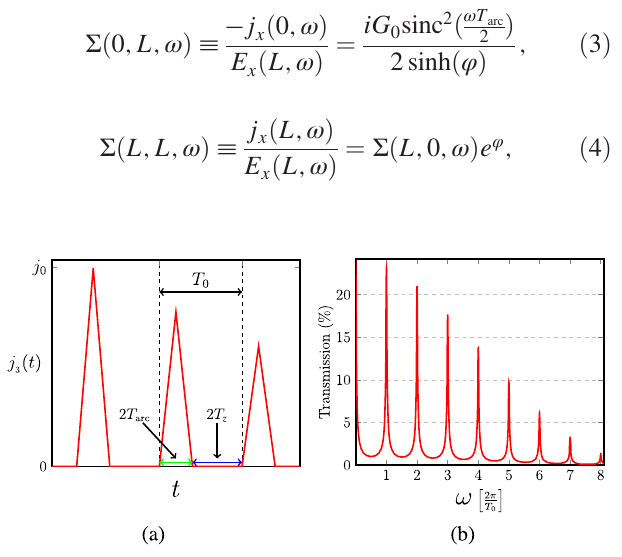
FIG. 3. (a) A sketch of real-time current on the lower surface ffiffiffiffiffiffiffiffiffiffiffi p 2 ℏ eB for j μ j < v 0 . In this case, the source of current decay is intervalley scattering. (b) The transmission coefficient as a function of the source frequency. A significant part of the radiation is transmitted whenever the frequency of the applied EM field is an integer multiple of ω 0 ¼ 2 π =T 0